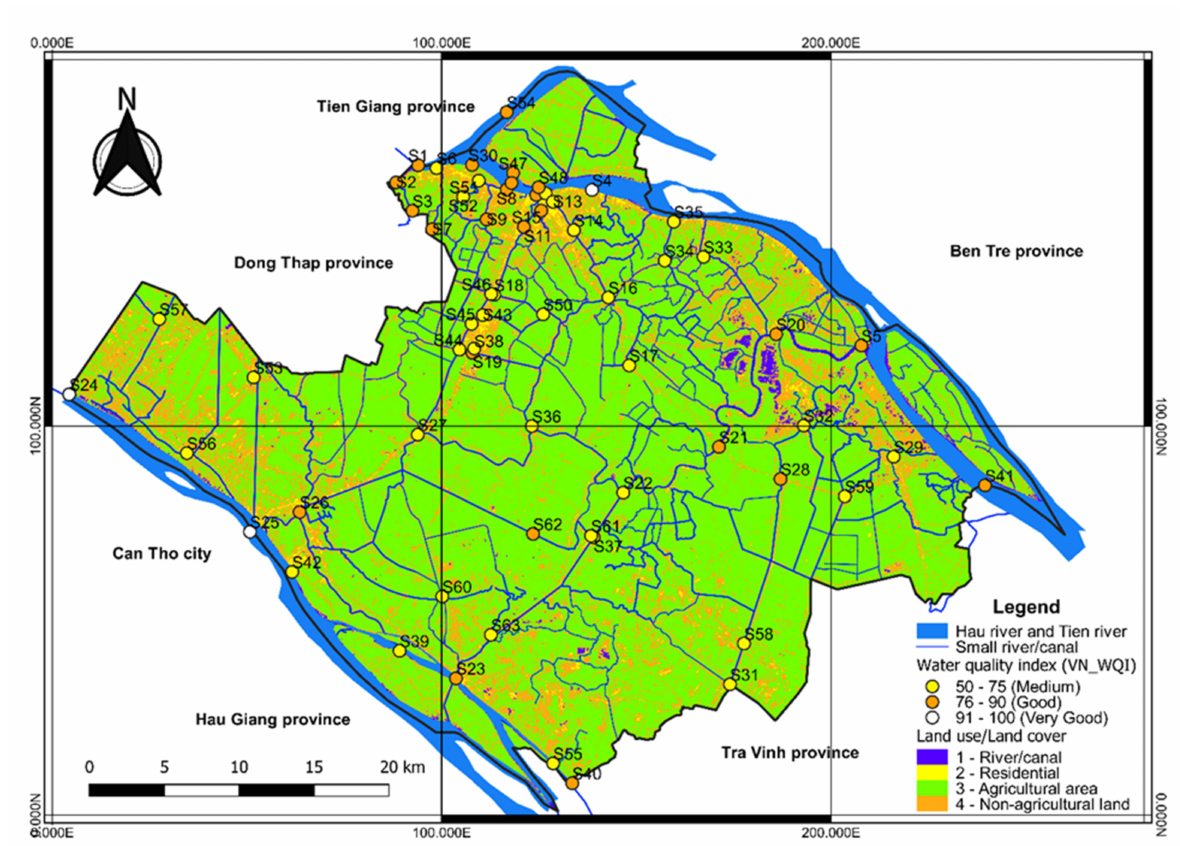
Figure 5. Spatial distribution of surface water quality by WQI.